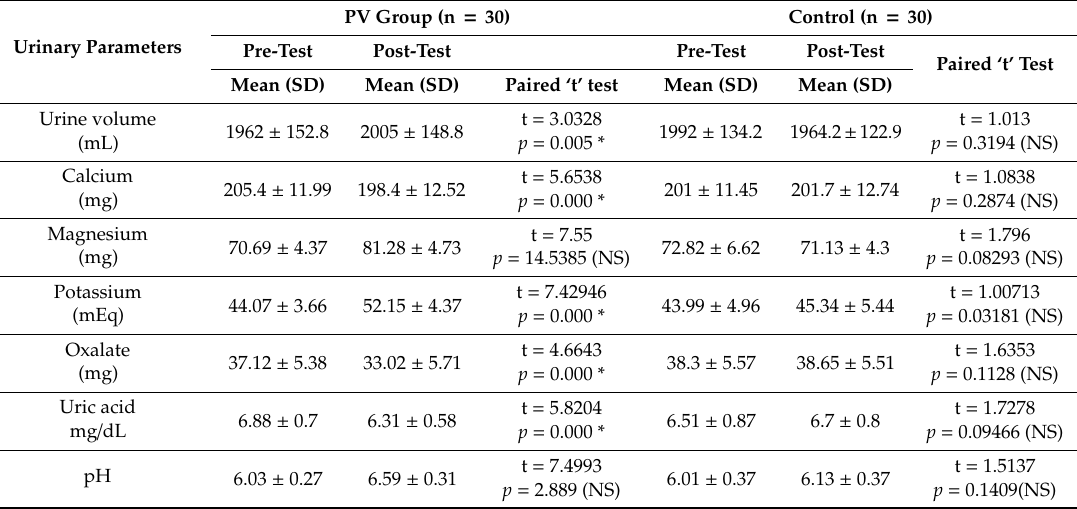
Table 4. Urinary Biochemical Parameters.